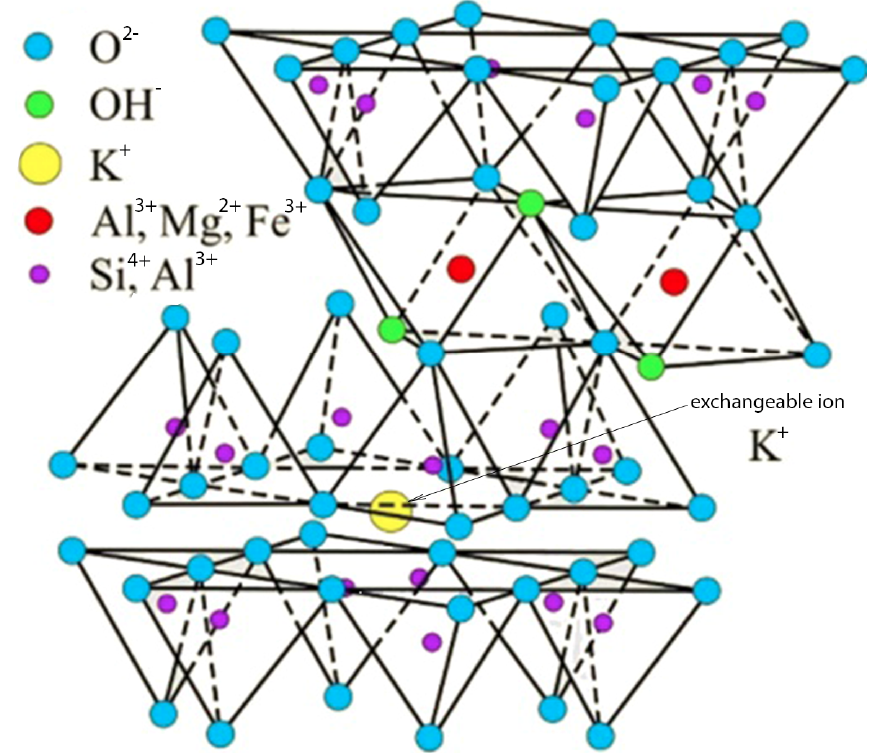
Figure 1. Crystal structure of illite. The exchangeable ion is K + .